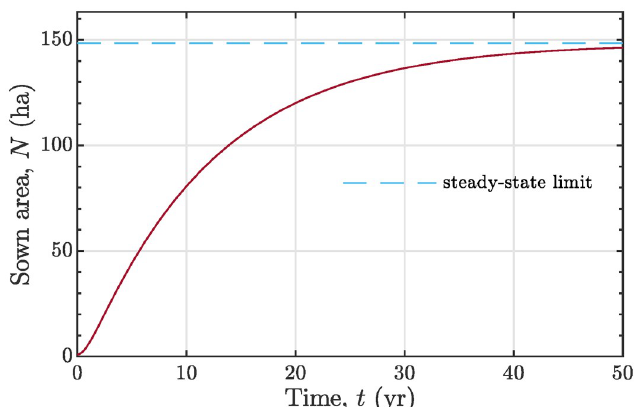
Fig 7. A hypothetical water-limited development of grassed acreage simulated with model (19). The total sown area tends via an S -curve to a steady-state size 148.4 ha. The initial conditions are R (0) = 0 and N (0) = 1 ha; water supply velocity is chosen to be r = 500 ton/yr. The other parameters of the model are given in the text.